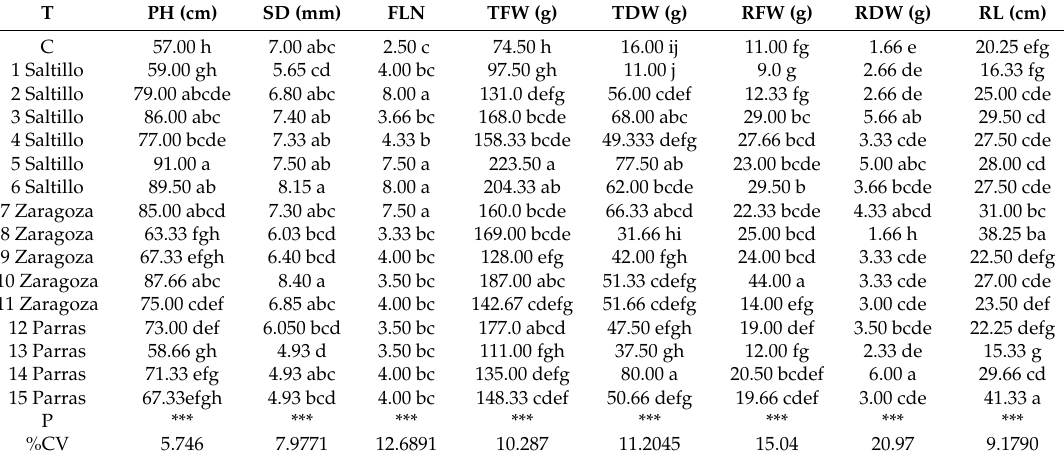
Table 7. Average effects (Tukey, p ≤ 0.05) of AMF on the agronomic parameters of greenhouse-grown tomato. The letter in the table is the result of the Tukey comparison test.